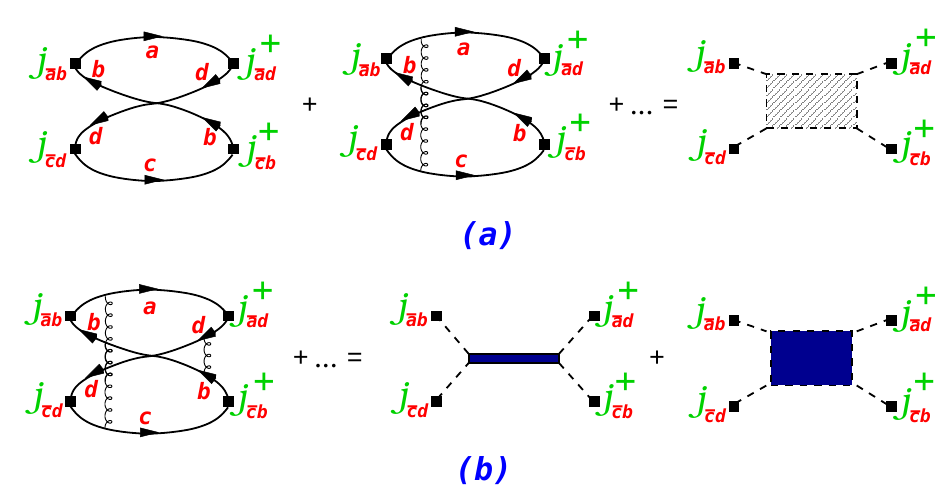
Figure 7. Flavour- reordering correlation function of four quark-bilinear operators [7], disintegrable into (a) an equation with no two-meson s -channel cut (hatched rectangle) and (b) a tetraquark-adequate QCD sum rule with two-meson s -channel cut (filled rectangle) and even tetraquark poles (blue horizontal bar).